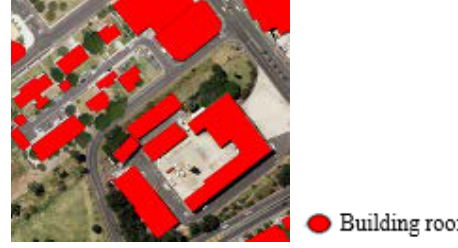
Figure 5. Final building roof extraction